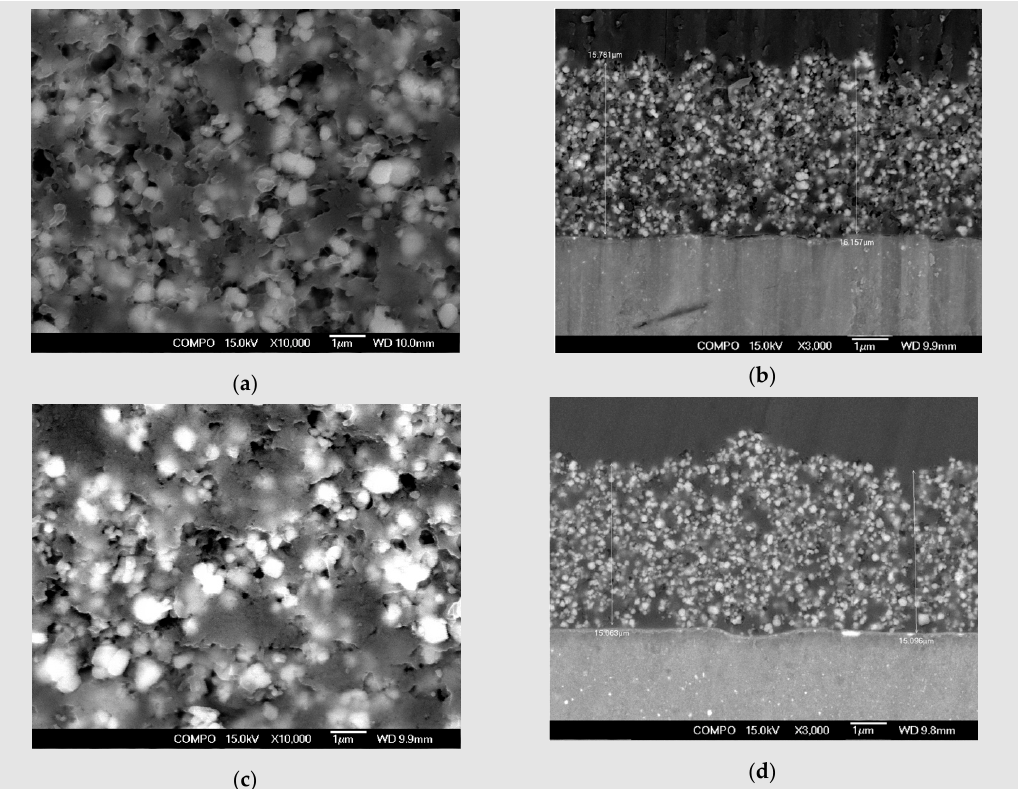
Figure 2. SEM micrographs of Mg alloys coated with HAP: ( a ) coated ZM21 plain view, magnification 10,000×; ( b ) coated ZM21 cross section view, magnification 3000×; ( c ) coated ZMX410 plain view, magnification 10,000×; ( d ) coated ZMX410 cross section view, magnification 3000×.